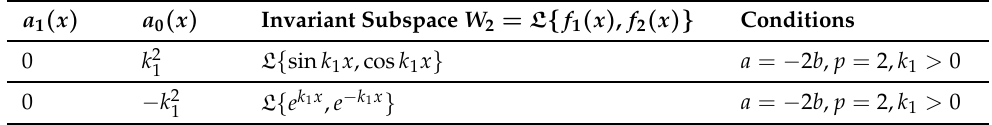
Table 4. Two-dimensional invariant subspaces W 2 of